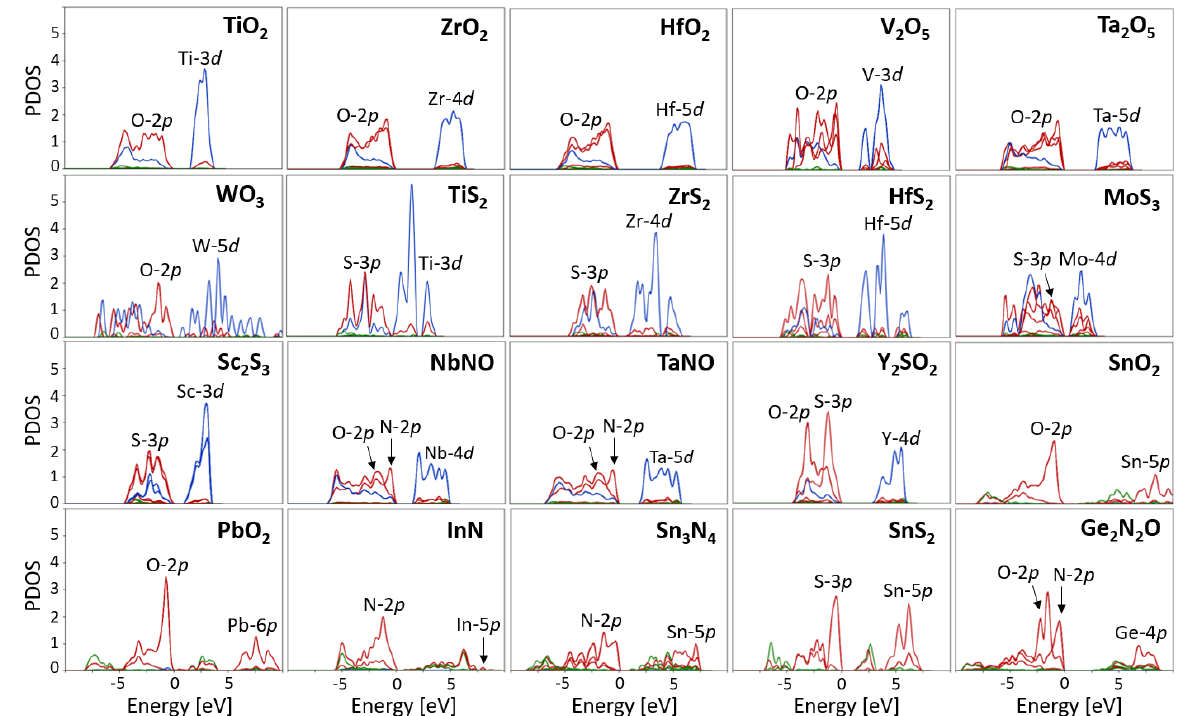
Figure 1. PDOS (in states/eV/cell) for all materials studied in this work obtained from standard DFT calculations. PDOS are color-coordinated such that s states are green, p states are red, and d states are blue. Note that cases where there are multiple lines of the same color indicate non-equivalent atoms. The zero of energy corresponds to the top of valence bands (except for InN which comes out to be metallic at the semilocal DFT level, and hence the zero of energy corresponds in this case to the Fermi